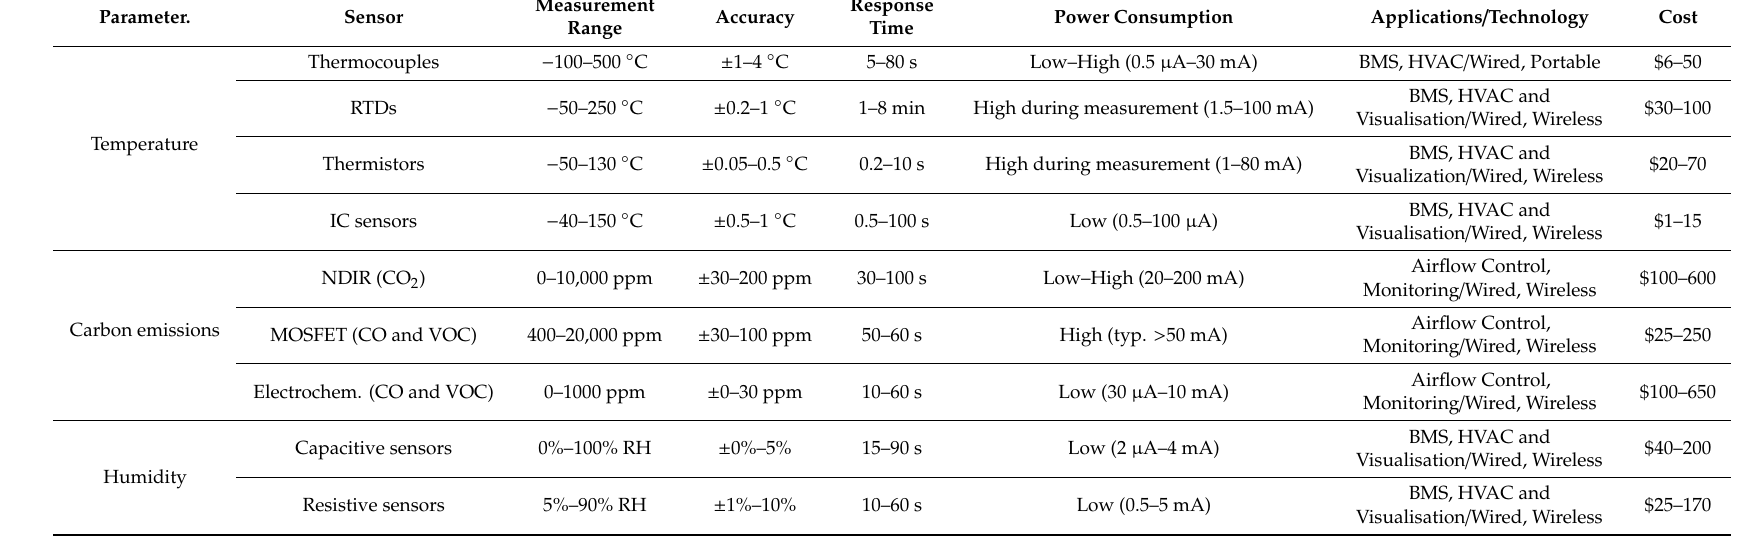
Table 1. Summary of the key characteristics of temperature, carbon emission, and humidity sensors used in buildings. Data has been deduced or calculated from published literature, and various manufacturer datasheets and user manuals available online at the time of publication.